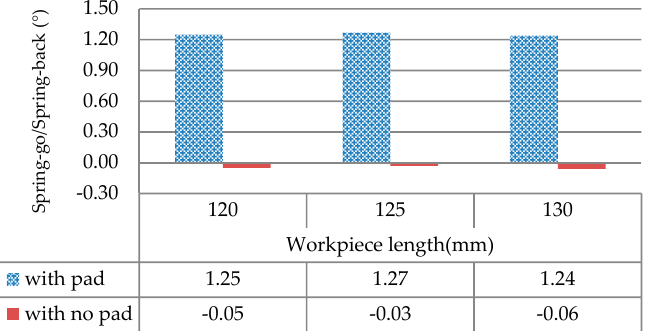
Figure 13. Comparison of the predicted spring-back/spring-go characteristics between the cases of U-bending with and without pressure pads, with respect to workpiece lengths ( θ : 90°, R p : 7 mm, W : 30 mm, t : 3 mm, R ud : 5 mm).